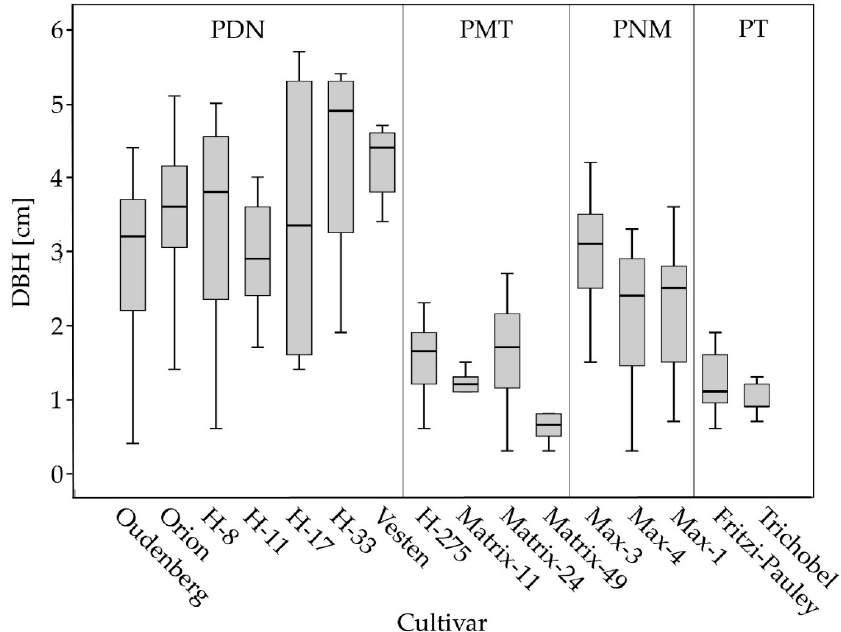
Figure 5. Box plots of DBH in Almaty at the end of the growing season 2019. Parentages: PDN— P. deltoides x nigra , PMT— P. maximoviczii x trichocarpa , PNM— P. nigra x maximoviczii , PT— P. tricho- carpa .